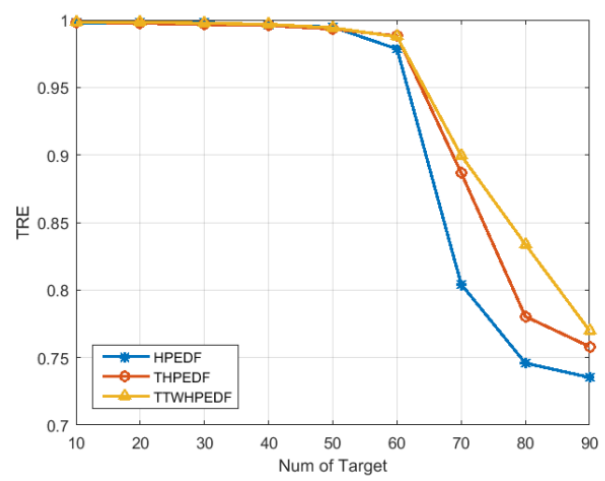
Figure 3. Comparison of the threat rate of the execution ( TRE ) for three scheduling algorithms.